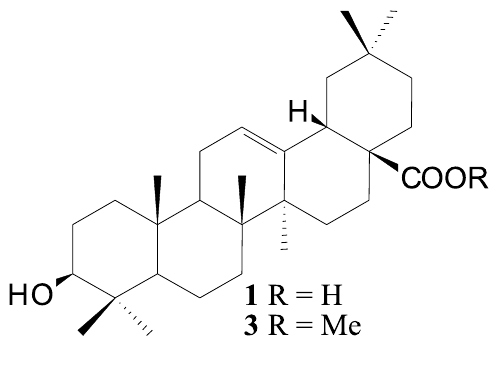
Fig. 1 – Structure of oleanolic acid ( 1 ) and of its methyl ester derivative ( 3